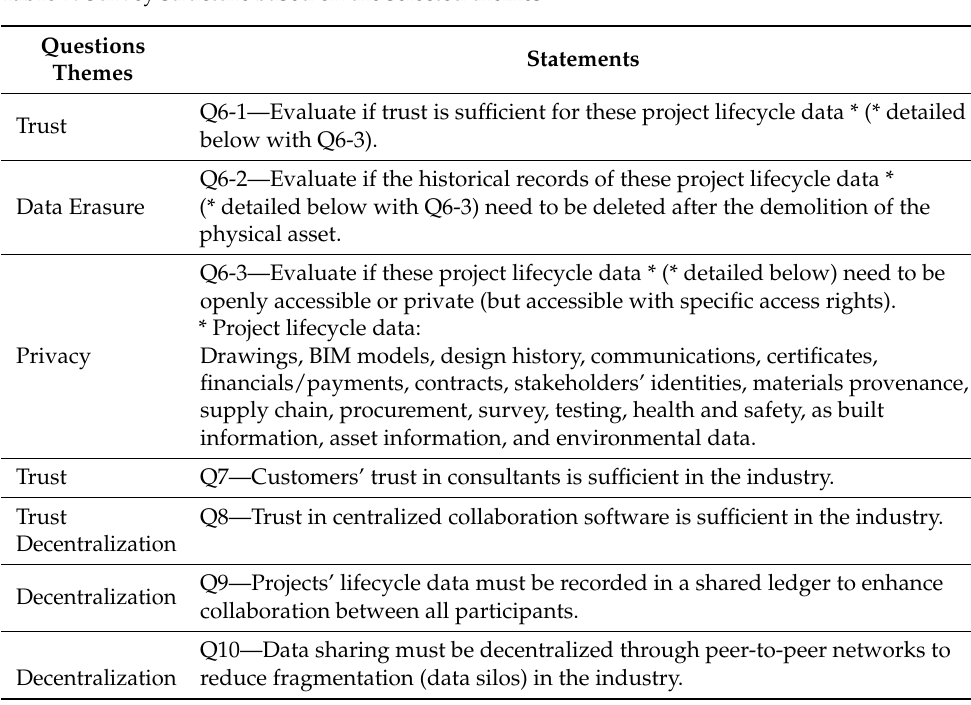
Table 7. Survey structure based on the selected